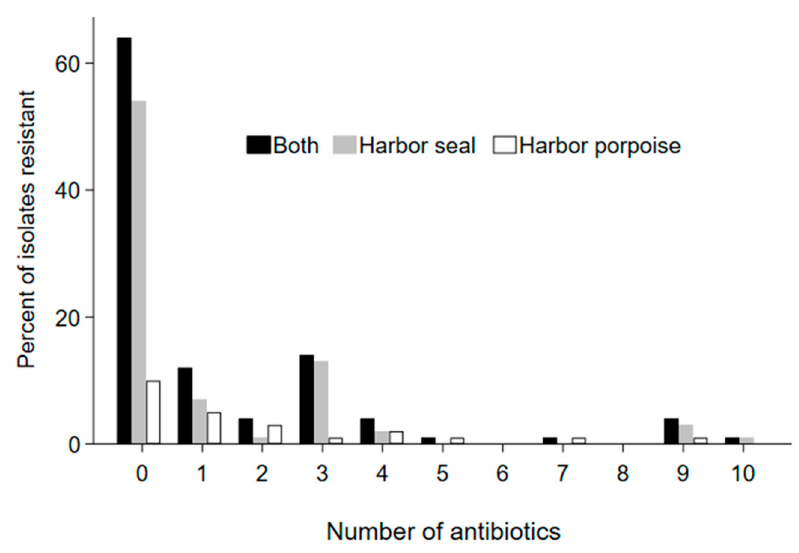
Figure 2. Percentage of bacterial isolates from dead stranded harbor seals and porpoises with antibiotic resistance based on the number of antibiotics to which the isolate was resistant.